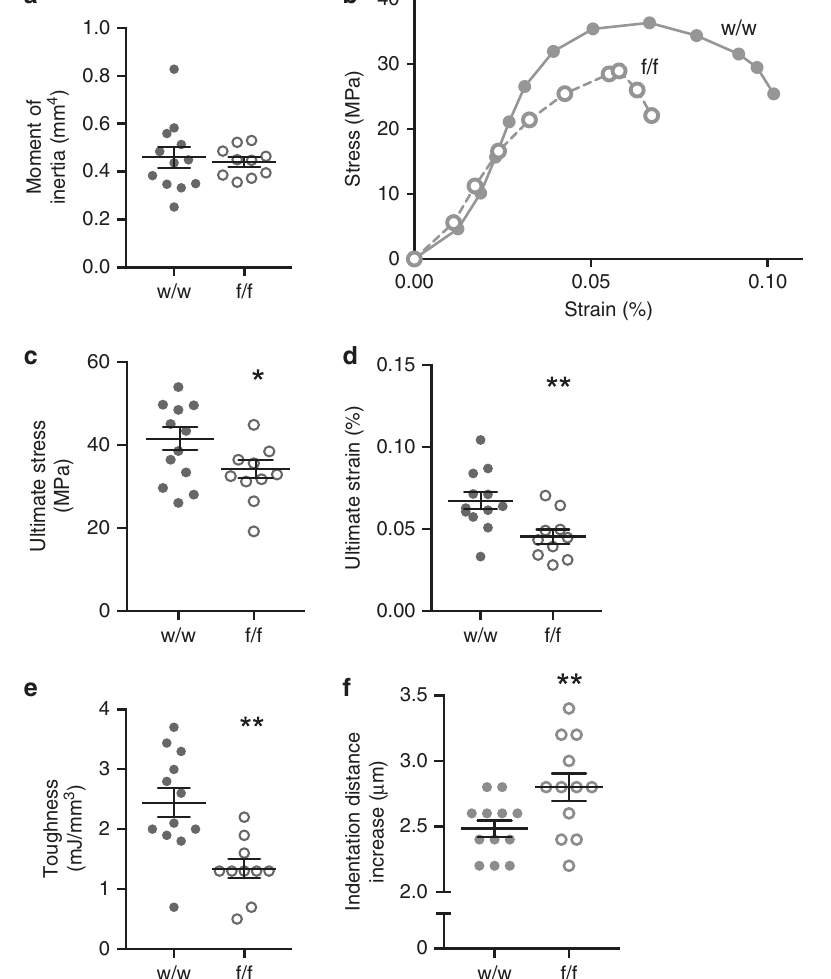
Fig. 2 Impaired strength in Dmp1Cre.Efnb2 f/f mice is a material defect and is not caused by altered bone geometry. a Femoral moment of inertia. b – e Three- point bending test data corrected for bone cross-sectional area, including average stress – strain curve (each dot represents the average load and deformation for the noted sample group; error bars excluded to highlight the shape of curves) ( b ), ultimate stress ( c ), ultimate strain ( d ), and toughness ( e ) of 12-week old female Dmp1Cre (w/w) and Dmp1Cre.Efnb2 f/f (f/f) femora. f Indentation distance increase derived from reference point indentation. Data are represented as mean ± SEM, n = 10 – 12/group. * p < 0.05, ** p < 0.01 vs. w/w controls by Student ’ s t